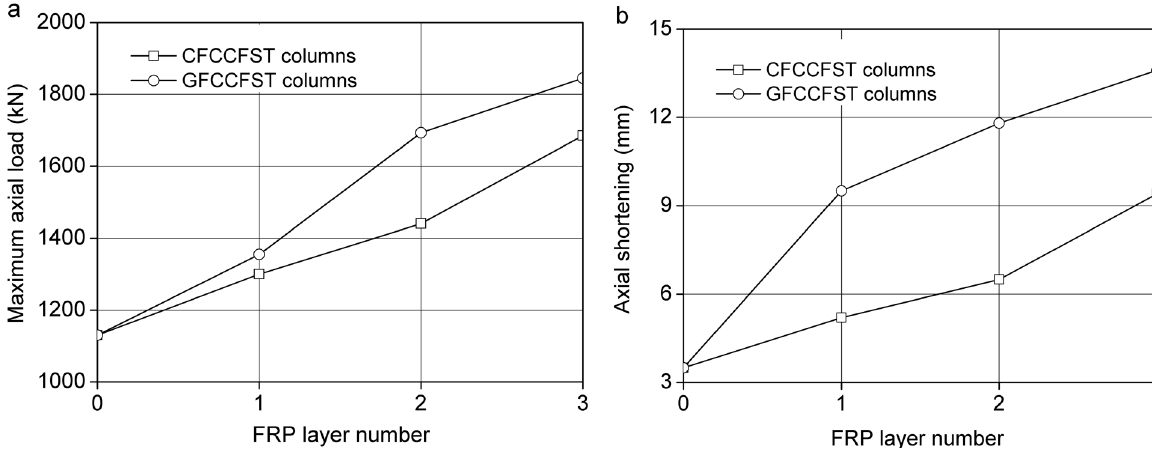
Figure 4. The effect of FRP confinement: ( a ) ultimate load; ( b ) axial shortening at the ultimate